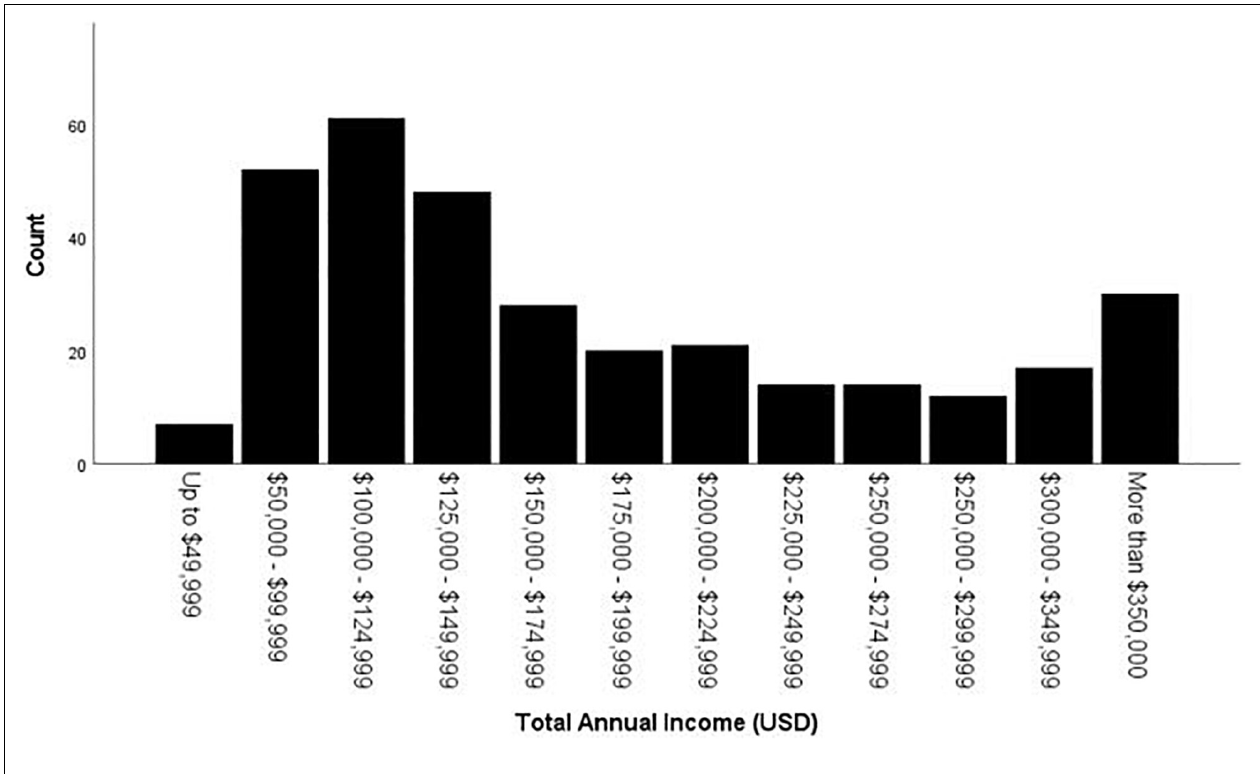
FIGURE 2 | Total annual income